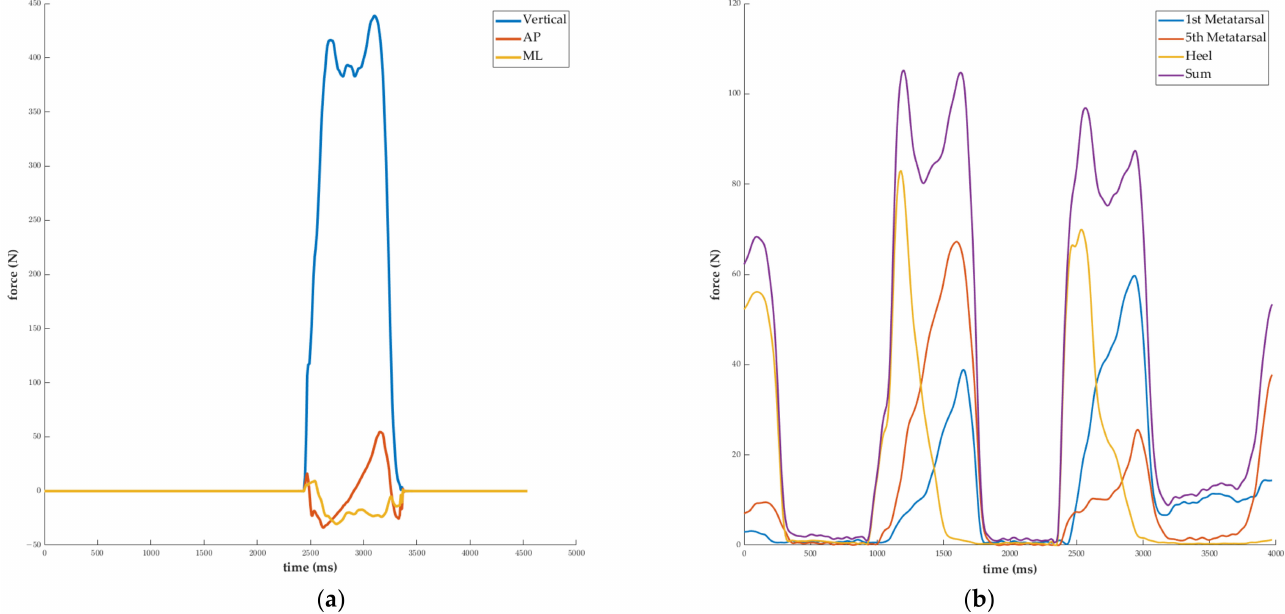
Figure 2. Typical signal from force plate and load cells. ( a ) Raw GRF measured from force plate. ( b ) Signal measured from three load cells and sum of three load cells during